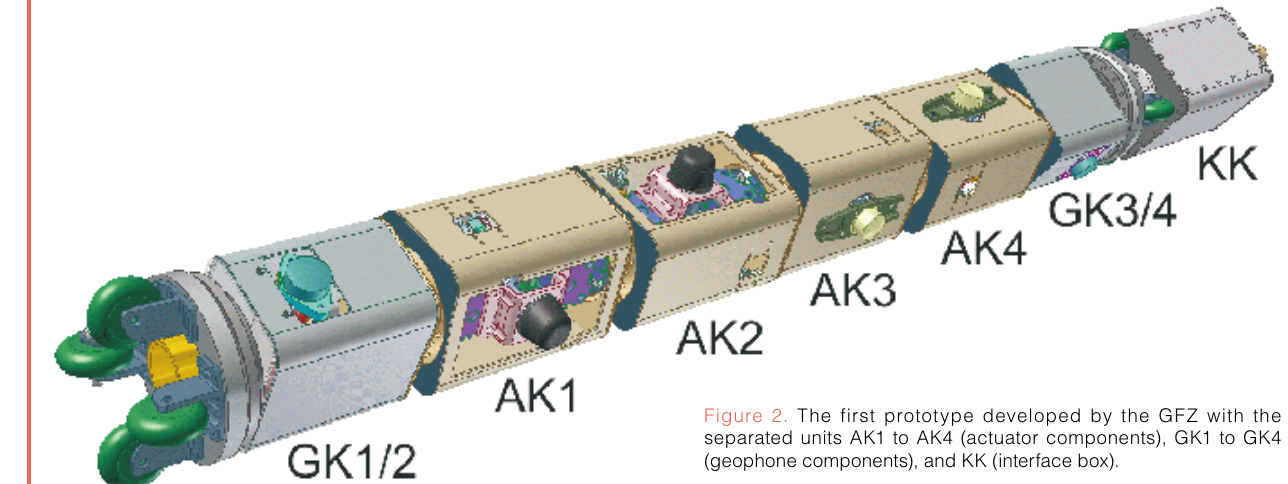
Figure 2. The first prototype developed by the GFZ with the separated units AK1 to AK4 (actuator components), GK1 to GK4 (geophone components), and KK (interface box).